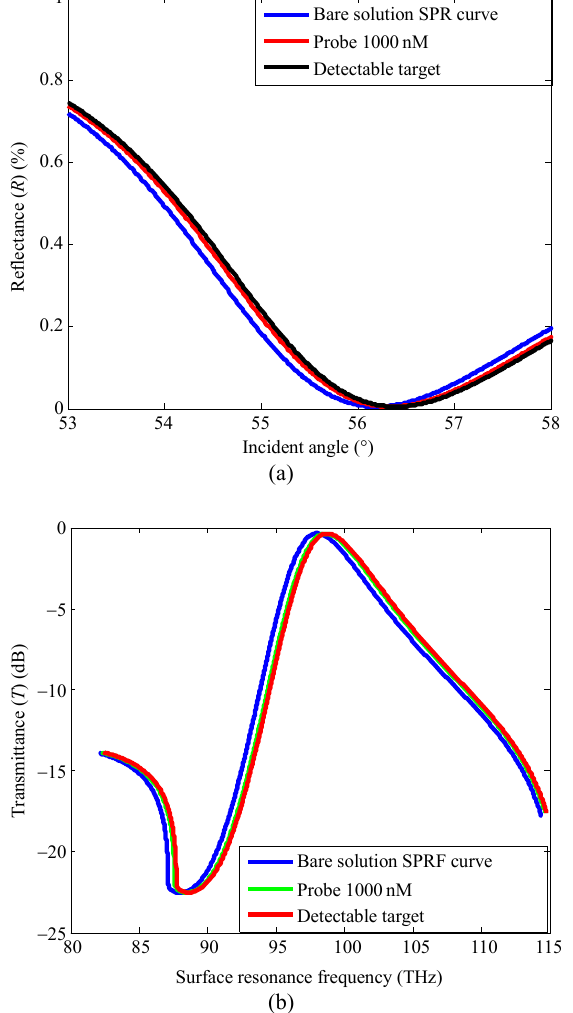
Fig. 2 SPR imaging curve of bare sensor: (a) R ~ θ SPR curves and (b) T ~ F SPR curves in the absence of formalin and presence of chitosan.